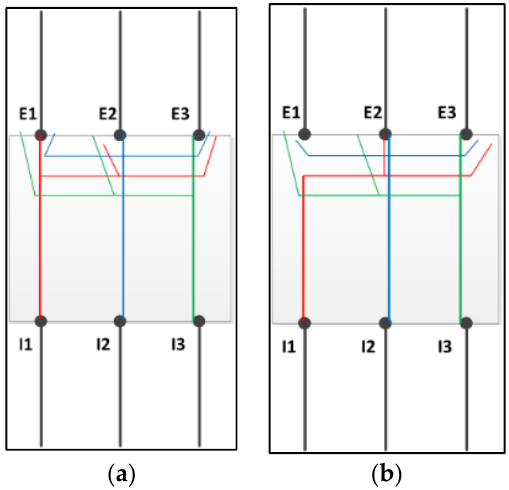
Figure 9. Structure of electricity circuits to switch data signals from an egress port to another egress port. ( a ) Switch S1 (I1 and E1) is in ON state; ( b ) MUXER turn of switch S1 (I1 and E1) and S1 goes in OFF state to open the connection of another circuit from I1 to E2 (no use of E1